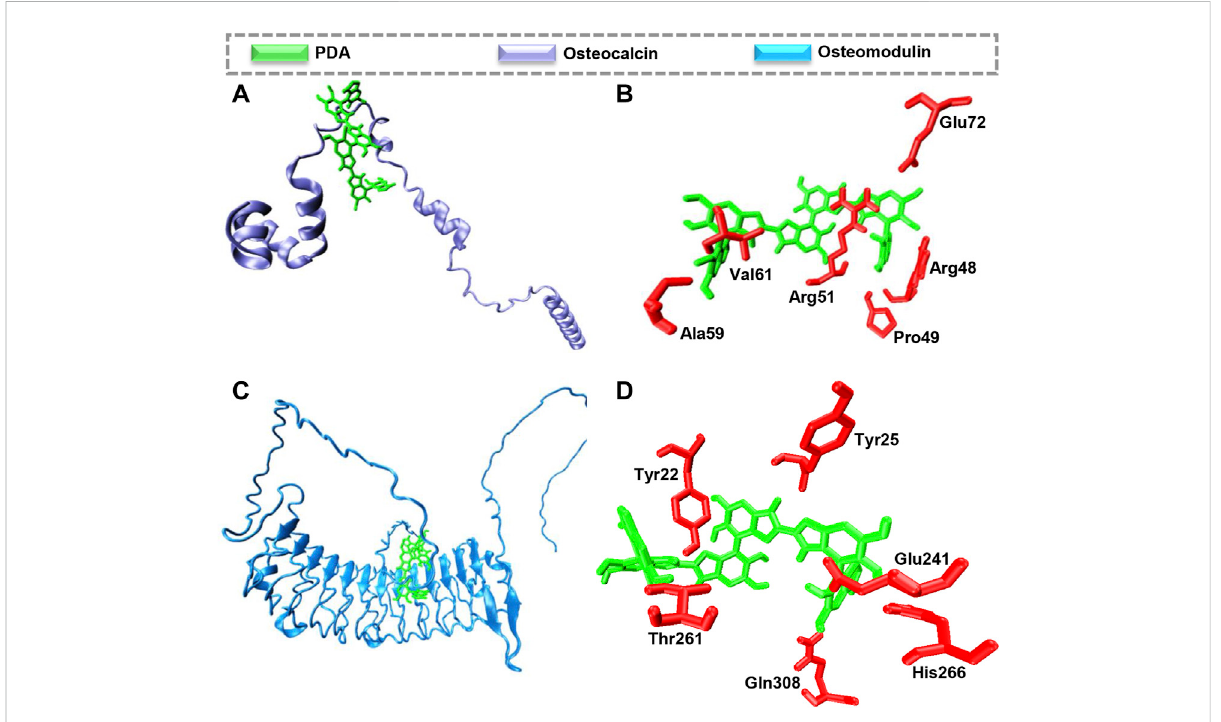
FIGURE 6 Molecular docking calculations of PDA interaction with osteocalcin and osteomodulin. The hydrogen bond is the driving force to form the proteins-PDA complex. (A) PDA binding to osteocalcin (B) , the best mode of PDA interaction with osteocalcin in the binding site, (C) PDA binding to osteomodulin (D) the best mode of PDA interaction with osteomodulin in the binding